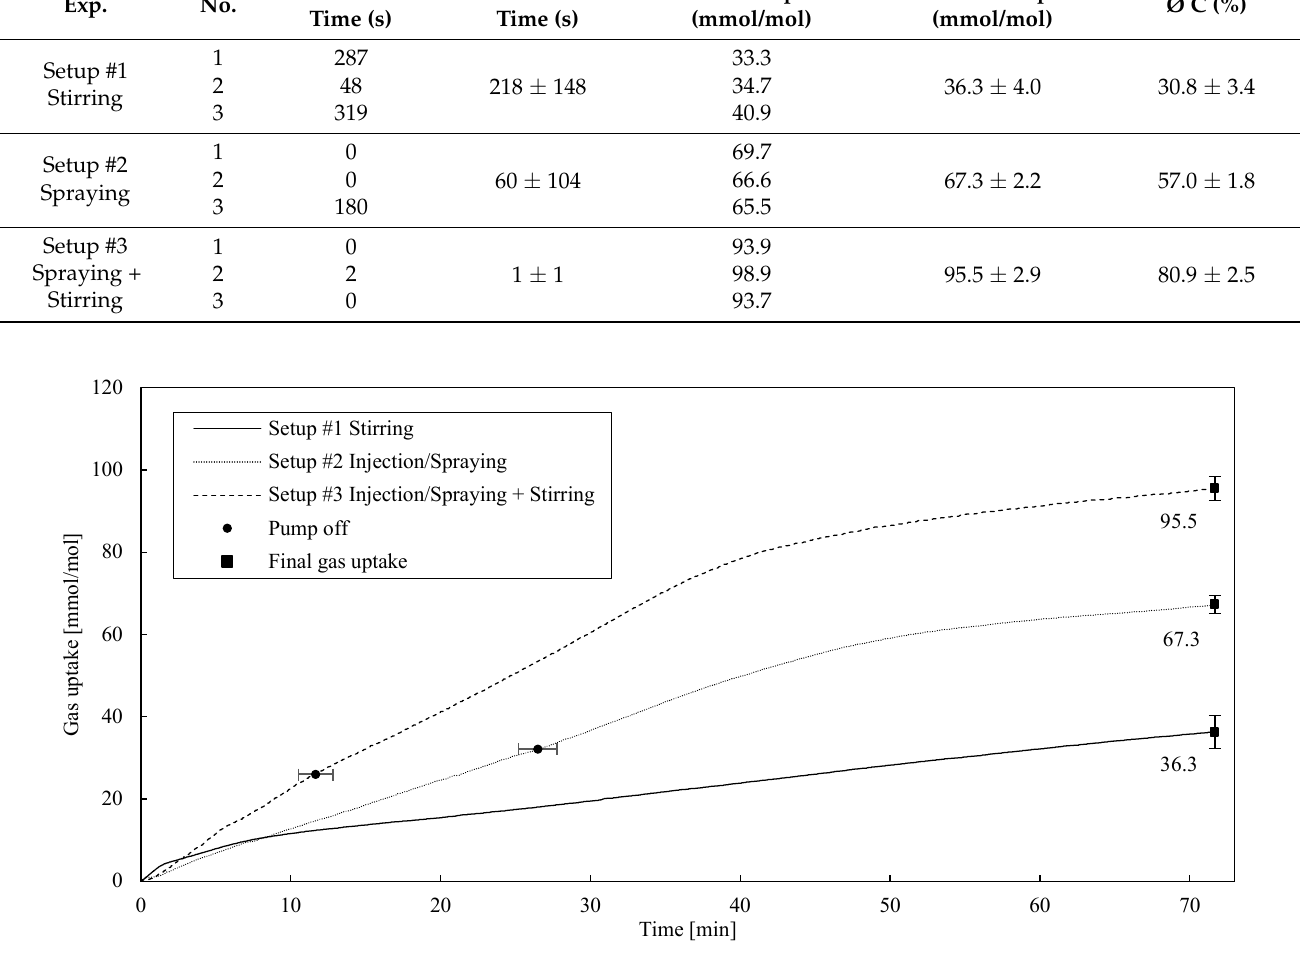
Figure 1. Gas uptake (mmol/mol) over time (min) for three different reactor setups.